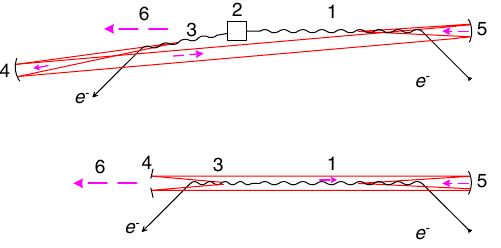
FIG. 6. Two schemes of the regenerative-amplifier FEL, ex- ploiting electron outcoupling technique. Top: with e -beam bend- ing. Bottom: with tapering. 1—main undulator, 2—achromatic bend, 3—outcoupling undulator section: bended (top) or tapered (bottom), 4 and 5—mirrors, 6—radiation from the main undu- lator. Radiation used for feedback is shown by red lines and small violet